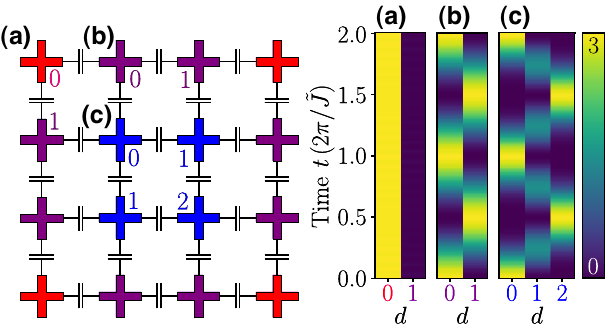
FIG. 5. Two-dimensional boundary effects for a single quasi- particle initially located at (a) a corner | 3 1,1 (cid:3) , (b) an edge | 3 1,2 (cid:3) , and (c) a nonedge site | 3 2,2 (cid:3) of a 4 × 4 transmon array. (a)–(c) The total occupation (cid:2)ˆ n d (cid:3) =